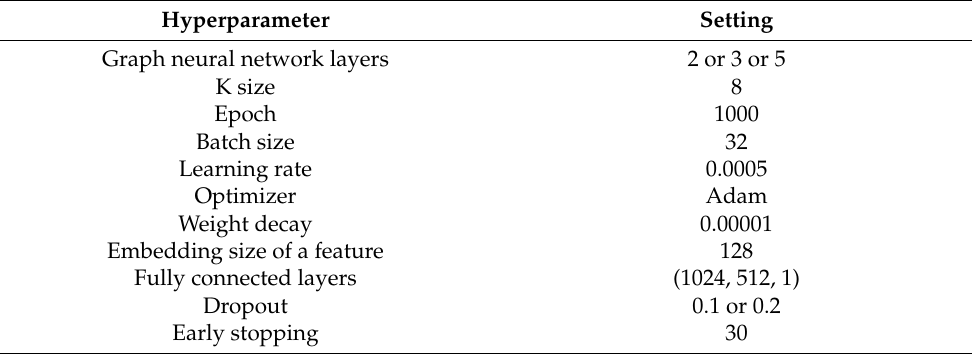
Table 5. Hyperparameters for the GraphATT-DTA